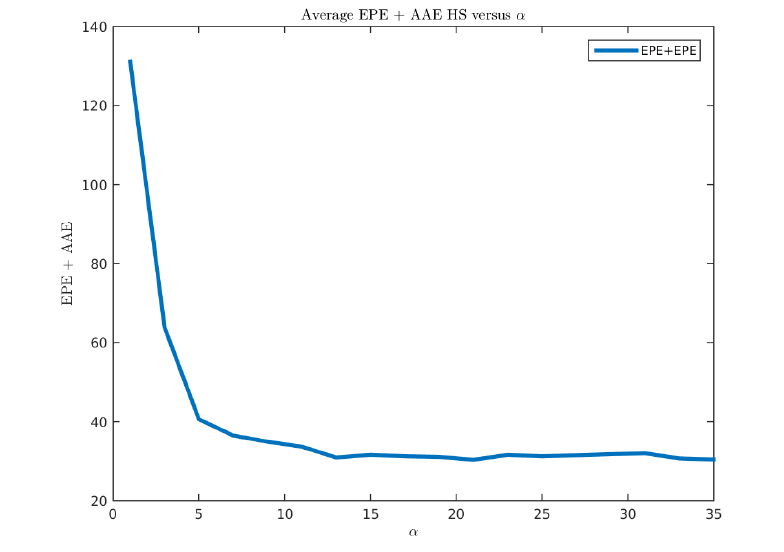
Figure 16. Performance of the Horn-Schunck method for different α hs values.